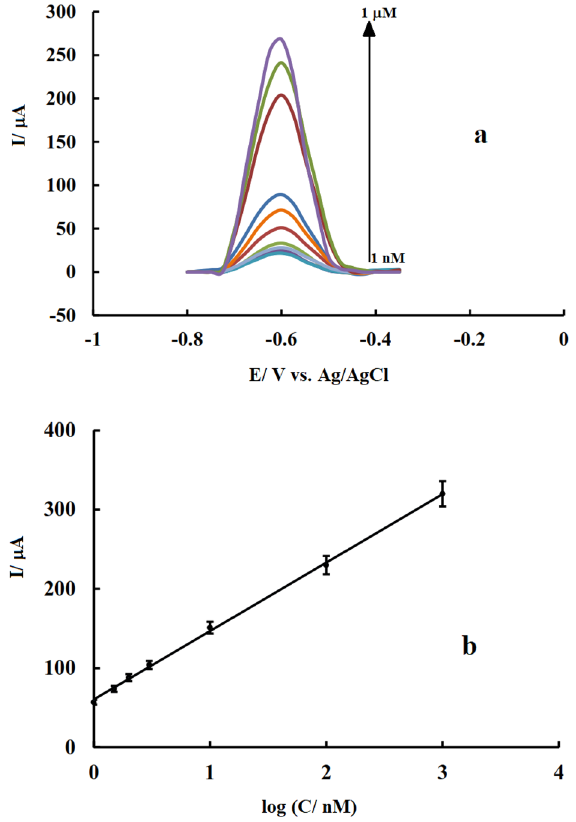
Figure 9. DPV response of l-Arg-RGO/GCE recorded after preconcentration applying − 0.8 V for 60 s to the electrodes immersed in a stirred solution of Pb(II) with different concentration (from 1 nM to 1 μM) ( a ); Calibration curve plotted from presented voltammograms. Accumulation condition: KCl (pH 6) applying − 0.8 V for 60 s; Stripping condition: Pb(II) free KCl solution with pH 6 ( b ); Scan rate: 0.1 V s −1 , Stripping condition: Pb(II) free KCl solution with pH 6.